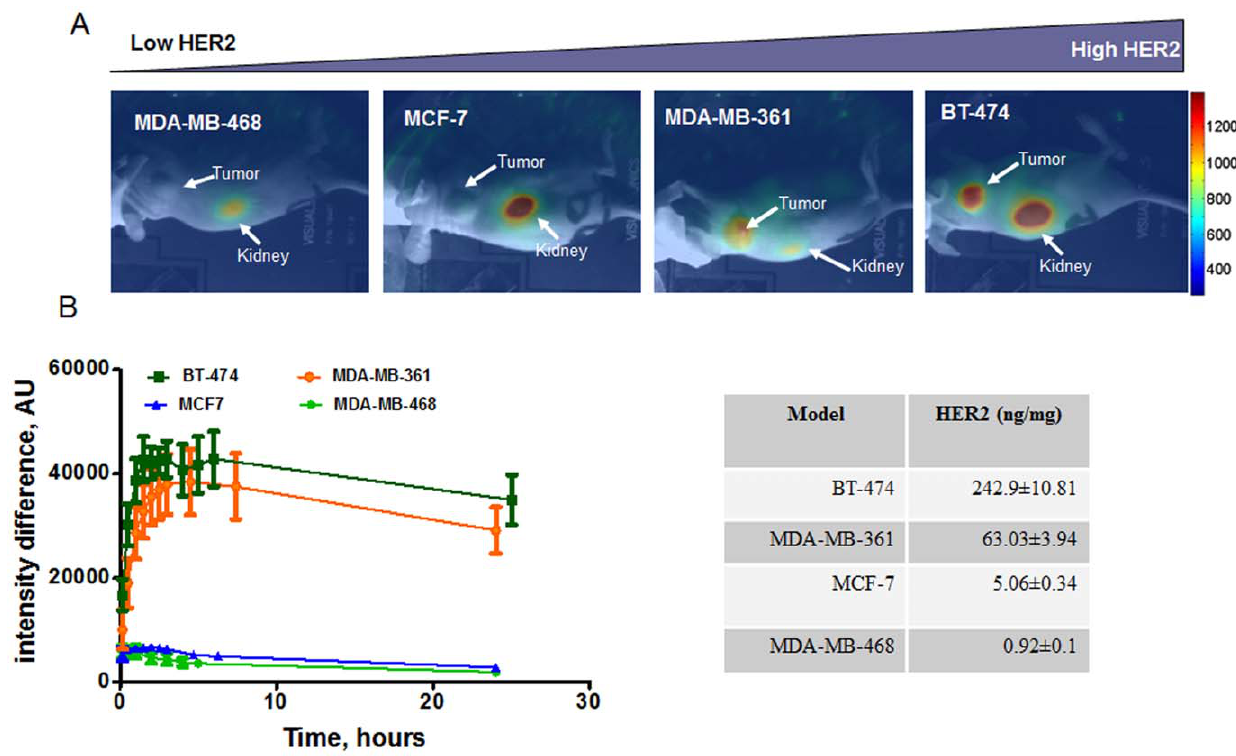
Figure 4. Accumulation of Z HER2 in xenografts with different HER2 expression level. 10 m g of Z HER2 -DyLight-750 conjugate were injected by IV into athymic mice bearing tumors expressing different levels of HER2 (A) CCD camera image of mice three hours post probe administration. (B) Tumor as well as contra-lateral area of animals were scanned at several time points (10 min to 24 h post injection) using in-house system with the scanning head, incorporating a linear array of source and detector fibers. Fluorescence signal is expressed as an intensity difference between tumor and contra-lateral site as described in Material and Methods Section. Table insert presents the level of HER2 measured in extracted tissue using HER2 ELISA and is expressed as nanogram of HER2 per mg of total protein.